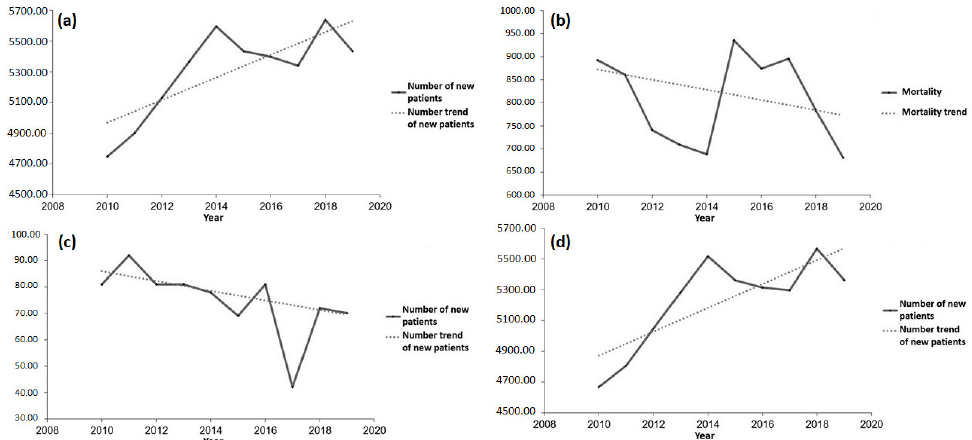
Figure 21. Results of the trends showing the number of new patients and those deceased from diabetes in the researched area: ( a ) overview of the number of new patients with both diabetes types from 2010 to 2019, ( b ) overview of the number of people who died from both diabetes types from 2010 to 2019, ( c ) overview of the number of new patients with type 1 diabetes from 2010 to 2019, ( d ) and overview of the number of new patients with type 2 diabetes from 2010 to 2019.